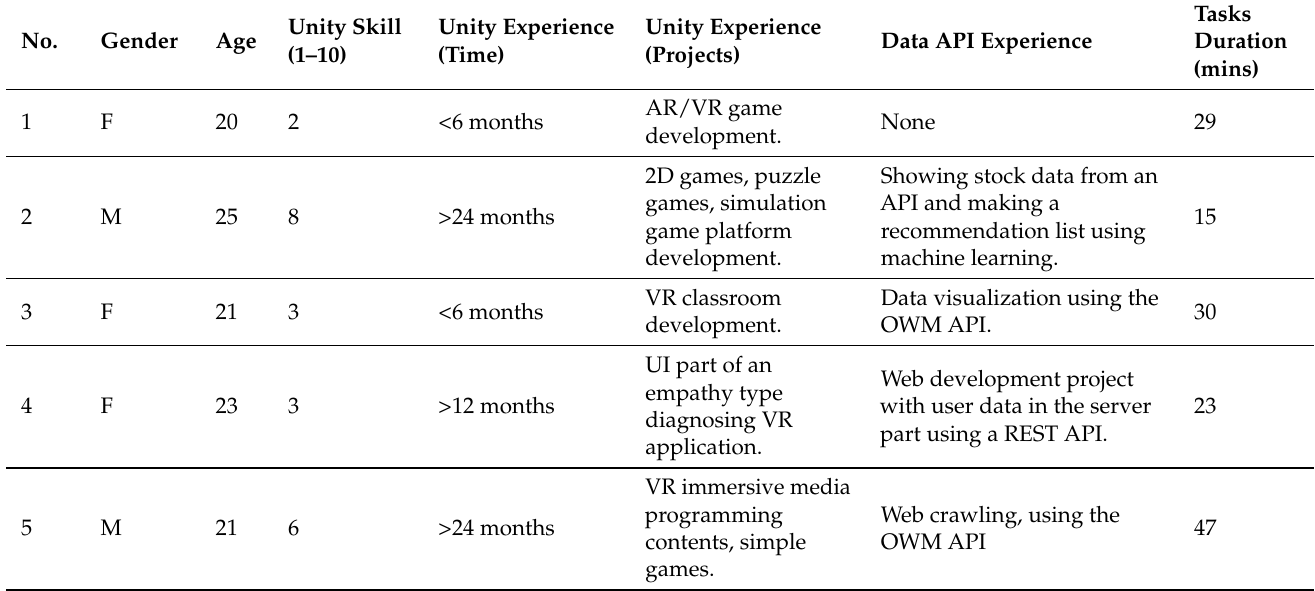
Table 3. Demographics, previous development experiences, and task duration results of the